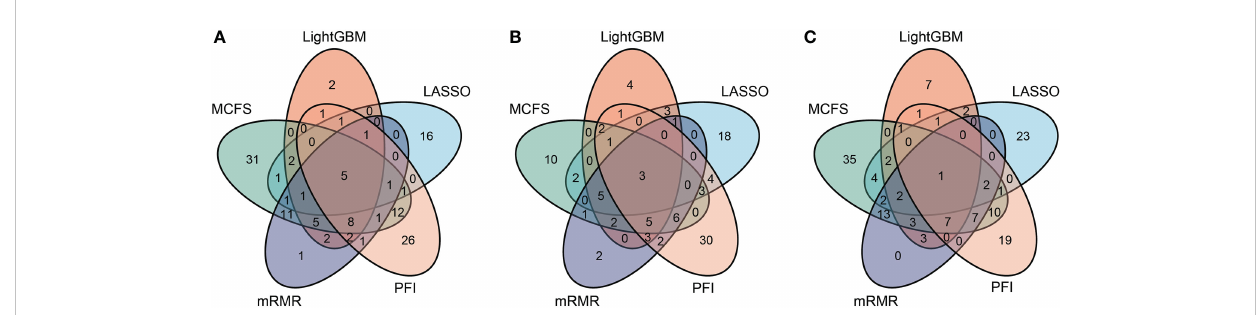
FIGURE 6 Venn results of fi ve essential feature subsets identi fi ed by fi ve feature ranking algorithms in three immune cell types. Genes found in multiple overlapping circles indicate that they were highly ranked in multiple ranking algorithms and were more likely to differ in homologous and